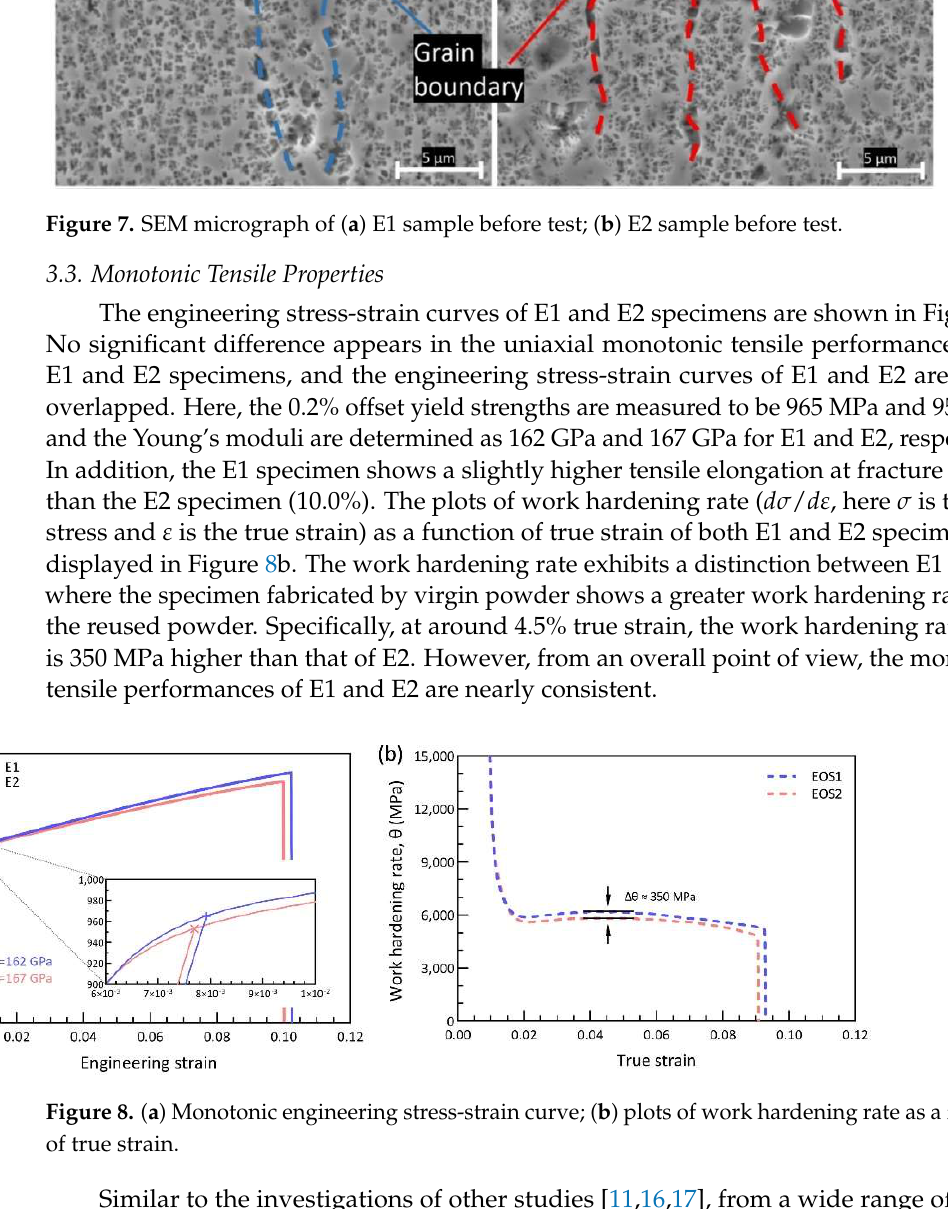
Figure 7. SEM micrograph of ( a ) E1 sample before test; ( b ) E2 sample before test.